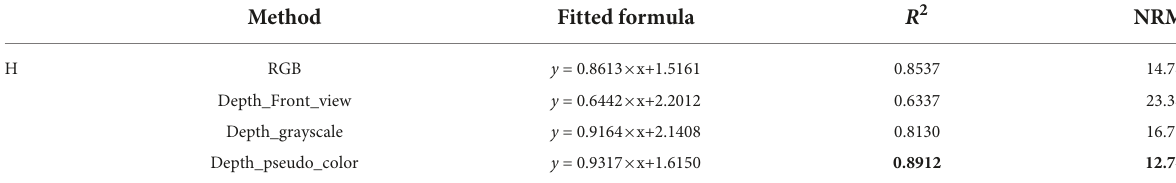
TABLE 8 Results of the estimated H by four date processing methods.